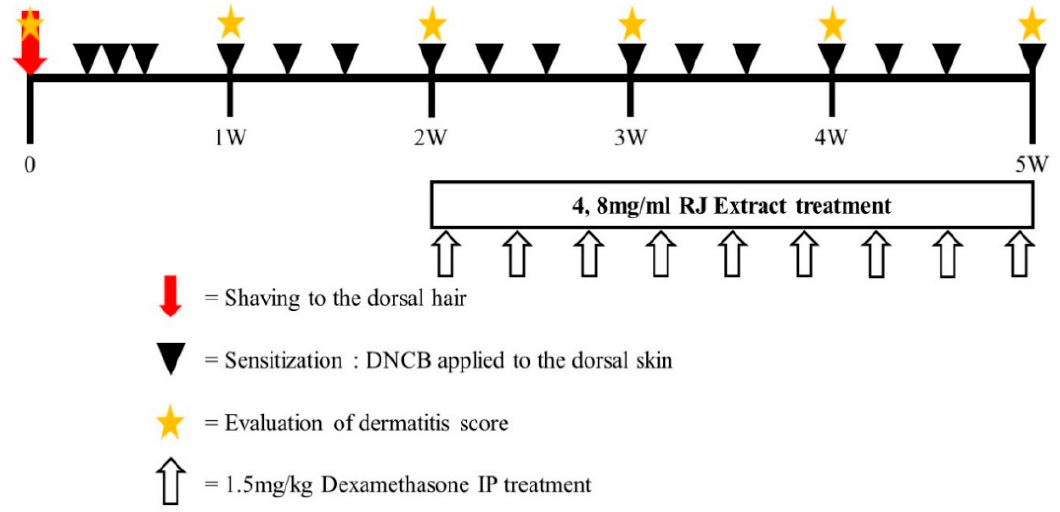
Figure 1. Experimental schedule for the induction of atopic dermatitis (AD) lesions. Mice were divided into five groups ( n = 5 per group). To induce AD-like immunological and skin lesions, DNCB was applied to the dorsal skin and ears.